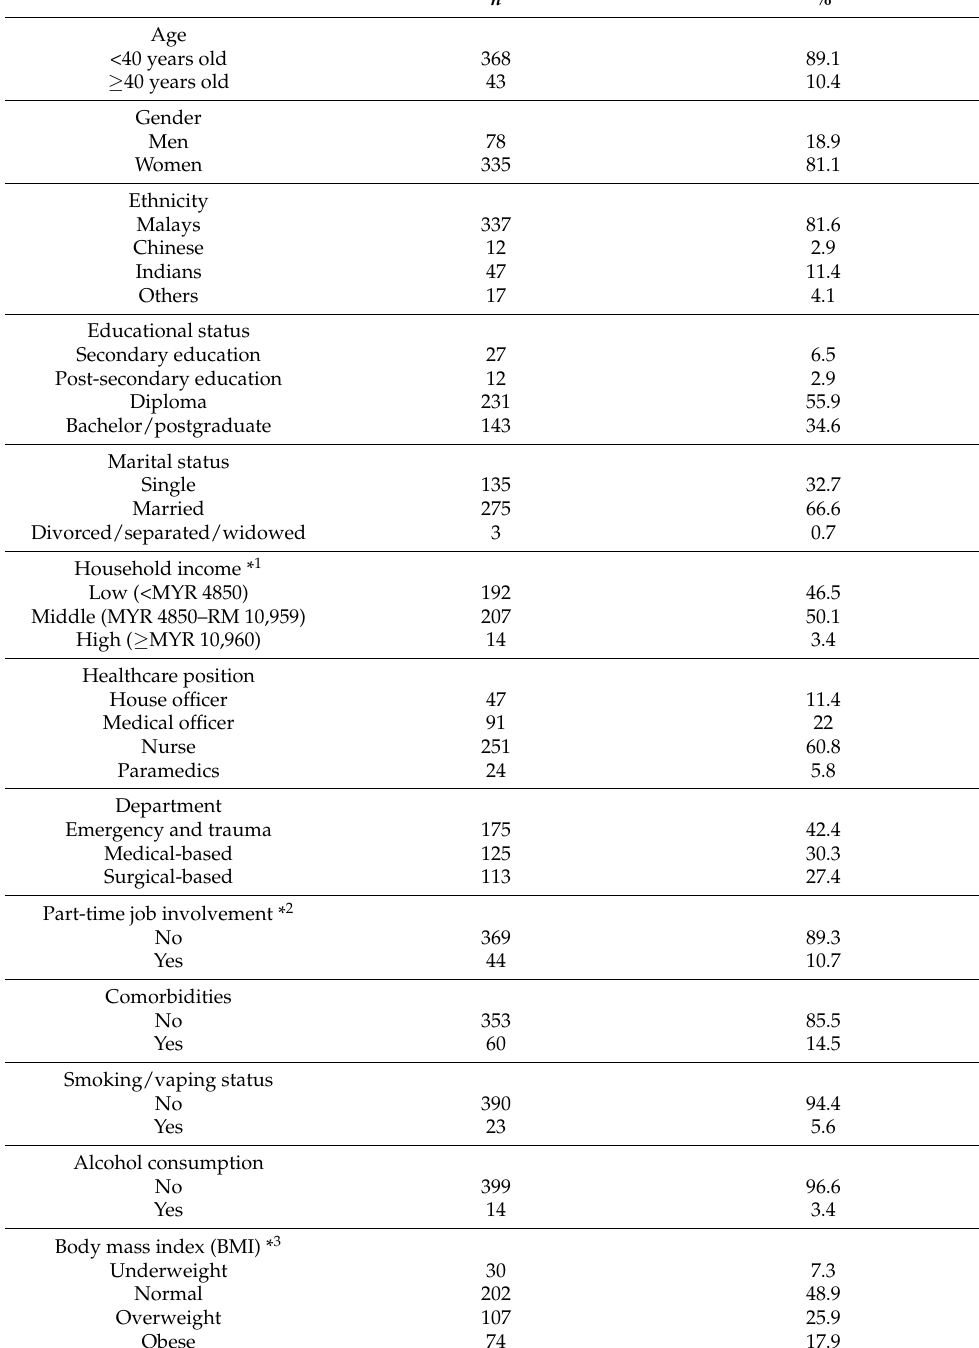
Table 1. Background of